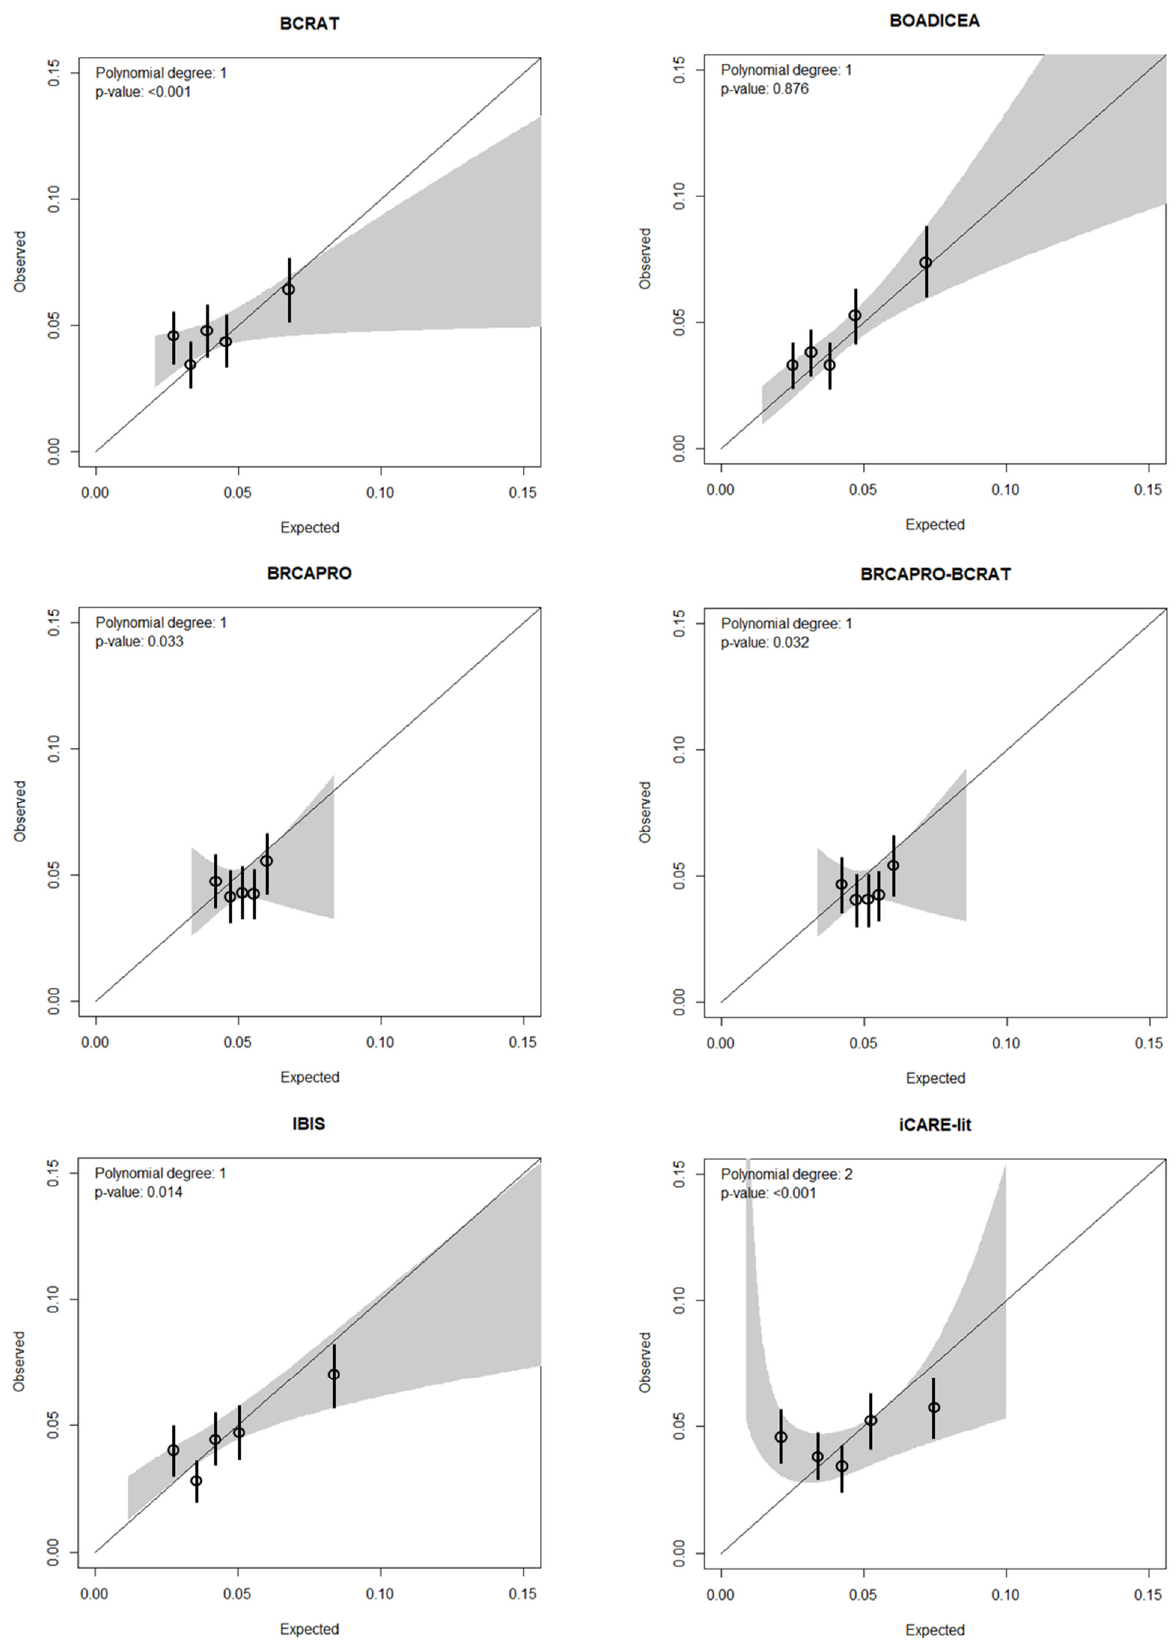
Figure 2. Calibration of 15-year breast cancer risk scores for six risk models across the risk spectrum.